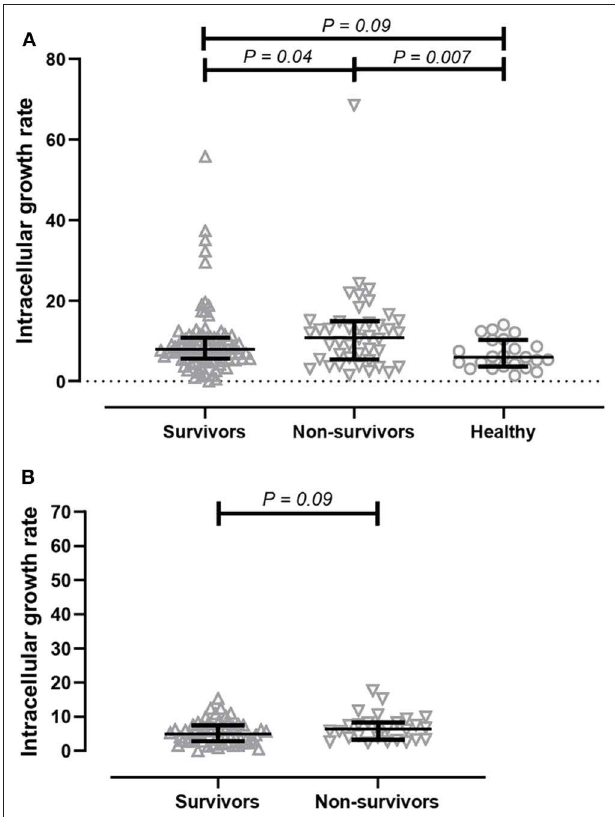
FIGURE 2 | Comparison of intracellular bacterial growth inhibition assay (GIA) in THP-1 derived macrophages. (A) GIA using serum from acute melioidosis patients who survived the disease (upward open triangles), acute melioidosis fatal cases (downward open triangles), and healthy endemic controls (open circle). (B) GIA using purified IgG antibodies from acute melioidosis patients who survived the disease (upward open triangles) and acute melioidosis fatal cases (downward open triangles). The result is expressed as fold change in CFU/ml at 7h post-infection compared to 3h post-infection. The statistical test used for comparison is the Kruskal-Wallis one-way ANOVA for more than two groups, and Mann-Whitney U for two groups.